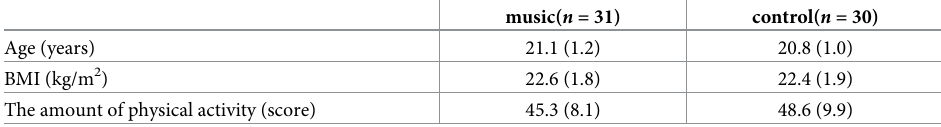
Table 1. Means and standard deviations for demographic characteristics. Mean ( SD